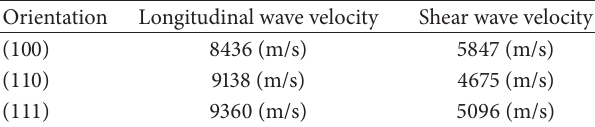
Table 1: Wave velocities in single-crystalline silicon wafer.